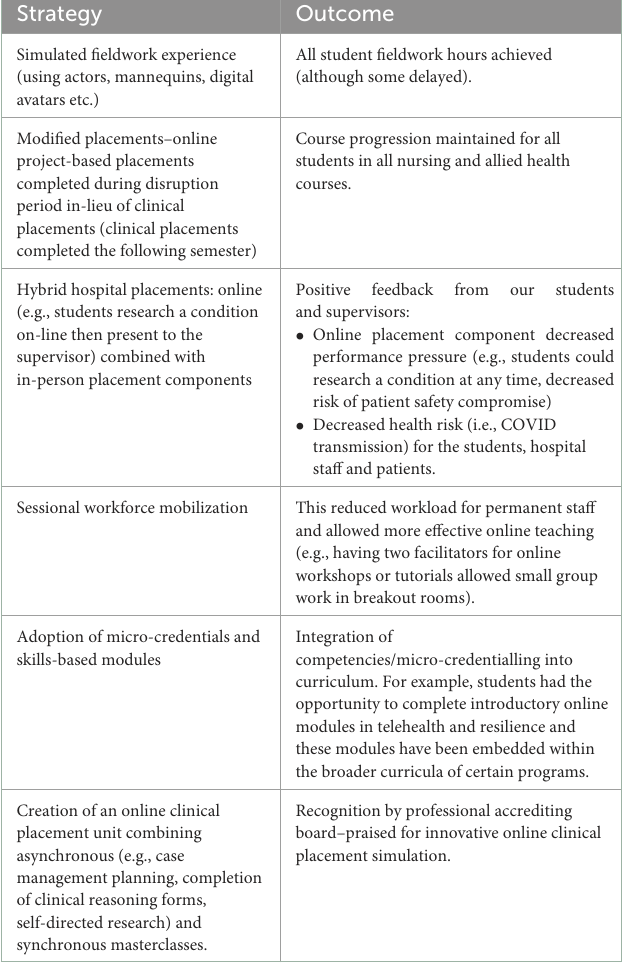
TABLE 4 Strategies generated and tested in COVID-disrupted years. Strategy Outcome Simulated fieldwork experience (using actors, mannequins, digital avatars